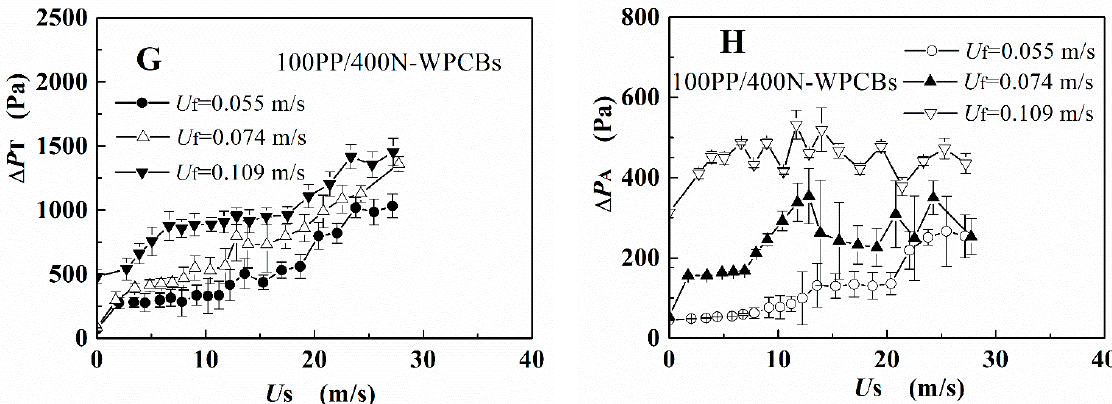
Figure 3. Results of the total pressure drop Δ P T and pressure drop in the annular region Δ P A by decreasing the spouting gas velocities with the addition of fluidizing gas. ( A ): Total pressure drop Δ P T for 100PP/25N-WPCBs ; ( B ): Pressure drop in annular region Δ P A for 100PP/25N-WPCBs ; ( C ): Total pressure drop Δ P T for 100PP/70N-WPCBs ; ( D :) Pressure drop in annular region Δ P A for 100PP/70N-WPCBs ; ( E ): Total pressure drop Δ P T for 100PP/150N-WPCBs ; ( F ): Pressure drop in annular region Δ P A for 100PP/150N-WPCBs ; ( G ): Total pressure drop Δ P T for 100PP/400N-WPCBs ; ( H ): Pressure drop in annular region Δ P A for 100PP/400N-WPCBs.